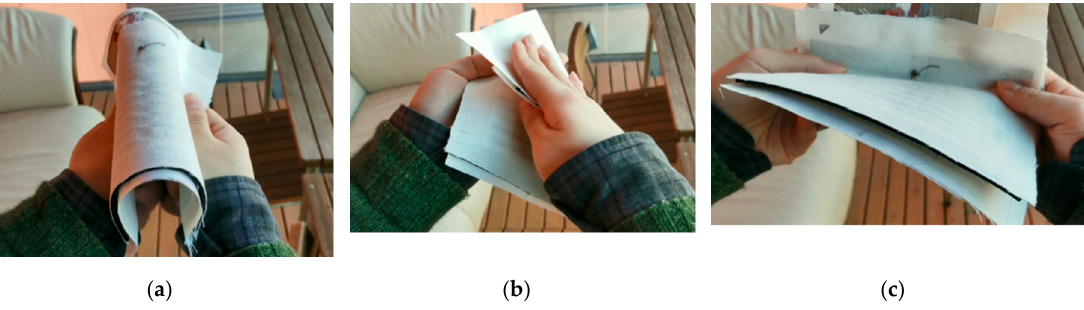
Figure 4. Initial stability test of the integrated circuits (IC) platform before writing. ( a ) Bent; ( b ) folded; ( c ) curved.